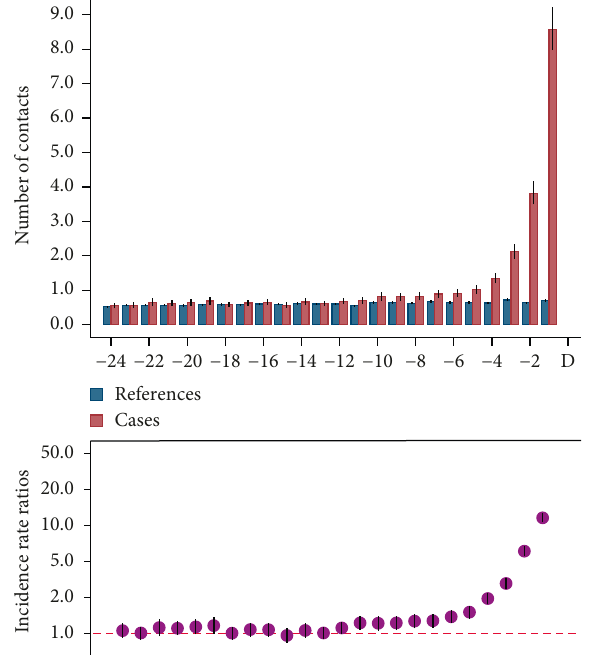
Figure 1: Monthly rates and incidence rate ratios (IRRs) for the total use of healthcare services for references and cases 24 months before the sarcoma diagnosis, with 95% confidence interval